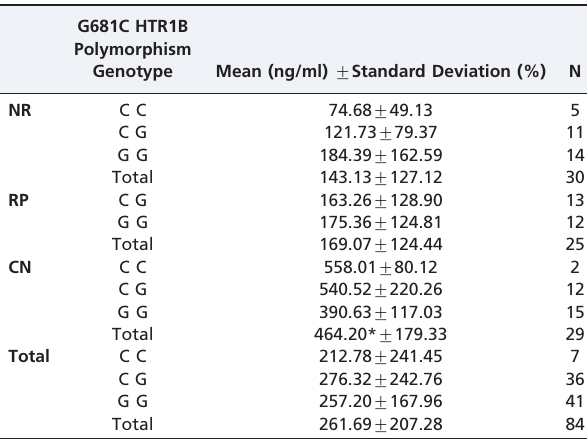
Table 3 - Platelet-rich plasma serotonin levels in the three study groups, stratified by the G681C HTR1B polymorphism.